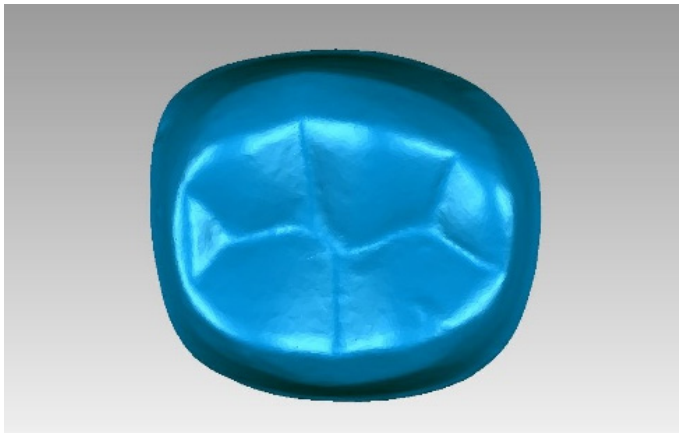
Figure 4. Stereolithography file of the tooth preparation.